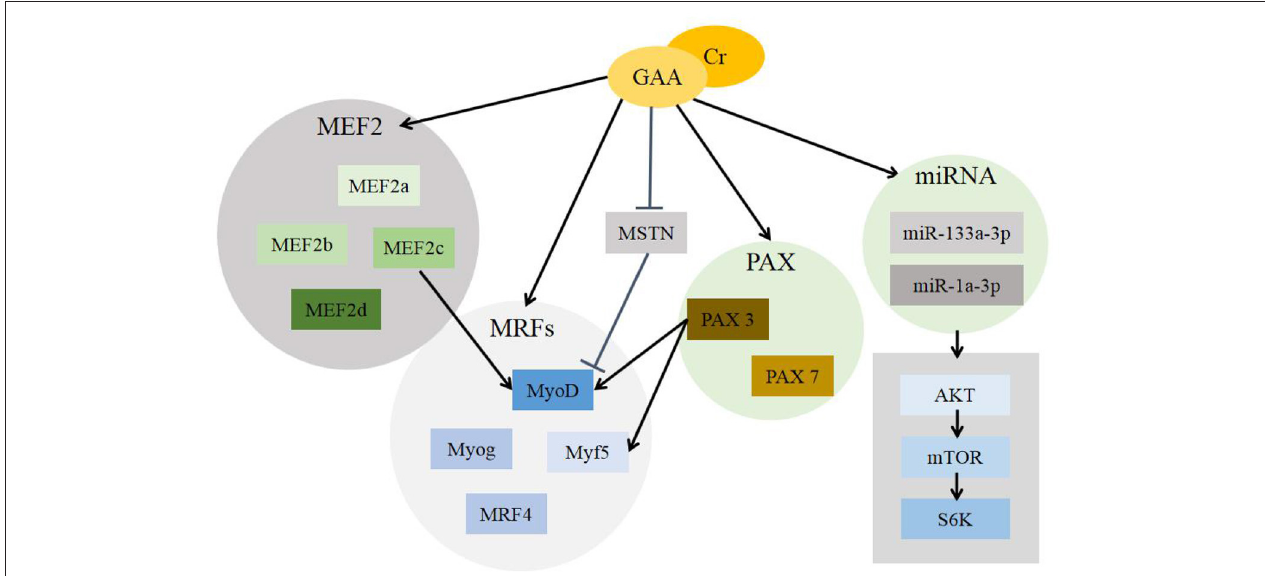
FIGURE 3 | Mechanisms of GAA/Cr promoting skeletal muscle development and growth. GAA, guanidinoacetic acid; Cr, creatine; MEF2, myocyte enhancer factor 2 (includes MEF2a, MEF2b, MEF2c and MEF2d); MRFs, myogenic regulatory factors (includes MyoD, Myog, Myf5, MRF4); MSTN, Myostatin; PAX, Pax gene family (includes Pax3 and Pax7); miRNA, MicroRNA (includes miR-133a-3p and miR-1a-3p); AKT, protein kinase B; mTOR, mammalian target of rapamycin; S6K, S6